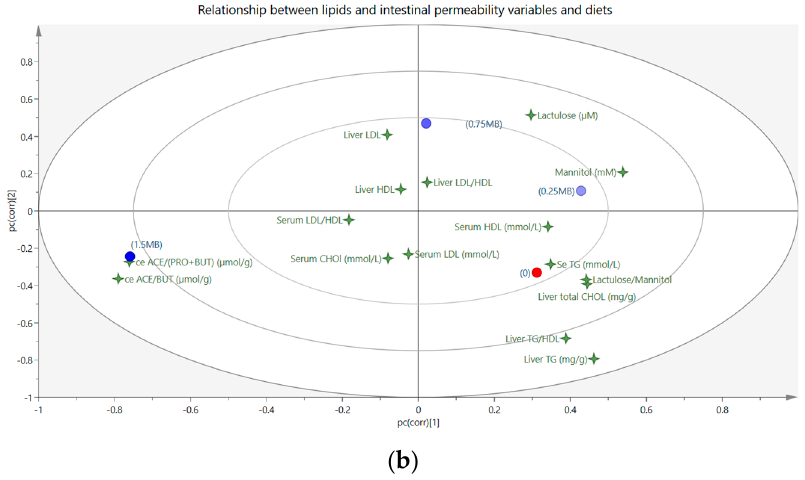
Figure 4. Lipid profiles and intestinal permeability in rats fed a high-fat control diet with butter (0), or the same diet supplemented with 0.25 MB g/100 g (dry weight basis) (0.25 MB), 0.75 MB g/100 g (0.75 MB), or 1.5 MB g/100 g (1.5 MB) for 3 weeks. ( a ) Score scatter plot shows separation of the treatment groups, especially 1.5 MB (green dashed line) compared to high-fat control diet with butter (0) (red dashed line), ( b ) loading scatter plot displays variables (4-point stars) of lipids and intestinal permeability in relation to the treatment groups (circles). Variables responsible for separation of groups fed the 0 and 1.5 MB diets are lactulose, mannitol, lactulose/mannitol ratio, liver total cholesterol, liver triglycerides, liver triglycerides/HDL-cholesterol ratio, cecal acetic acid-to-butyric acid ratio, and cecal acetic acid-to-propionic- plus butyric acids ratio. MB, monobutyrin; ACE, acetic acid; PRO, propionic acid; BUT, butyric acid; LDL, low-density lipoprotein-cholesterol; HDL, high- density lipoprotein-cholesterol; CHOL, cholesterol; TG, triglycerides.